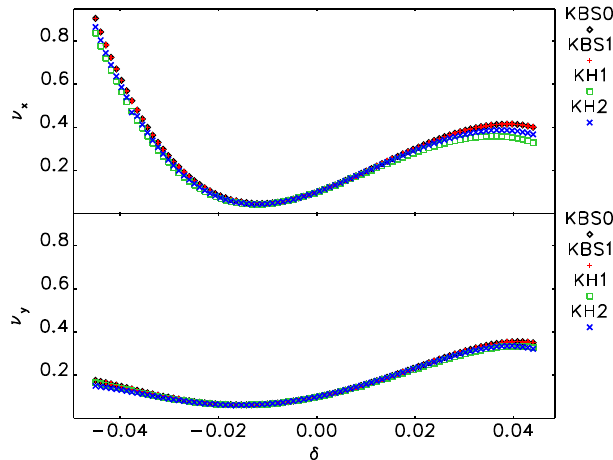
FIG. 2. Momentum-dependence of tunes from tracking with various bending magnet fringe models, after correction of the tunes and